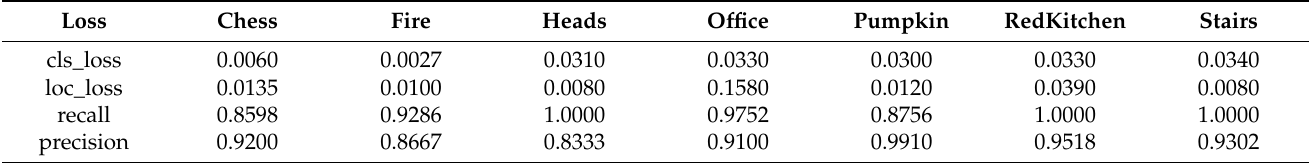
Table 1. Loss of object pose